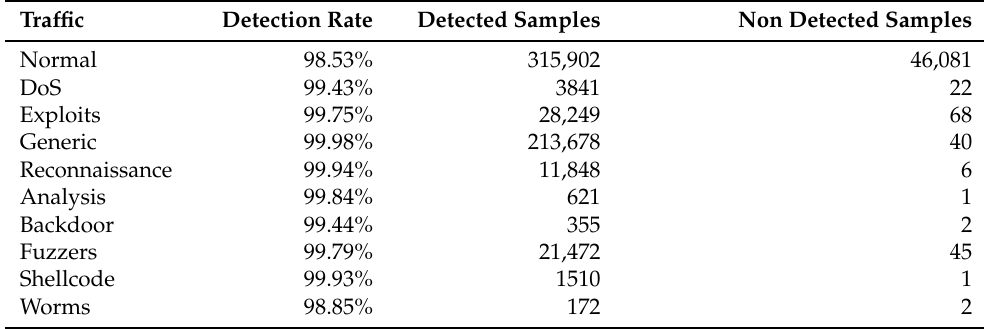
Table 11. Attack detection summary UNSW-NB15 dataset: Known and zero-day